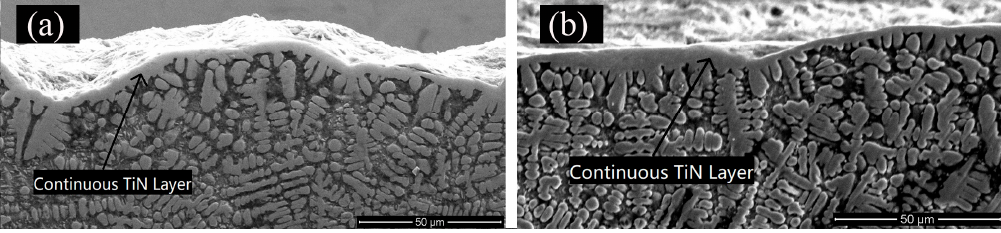
Figure 8. Micrograph of the transverse cross-section: ( a ) point A of Figure 2a; ( b ) point A of Figure